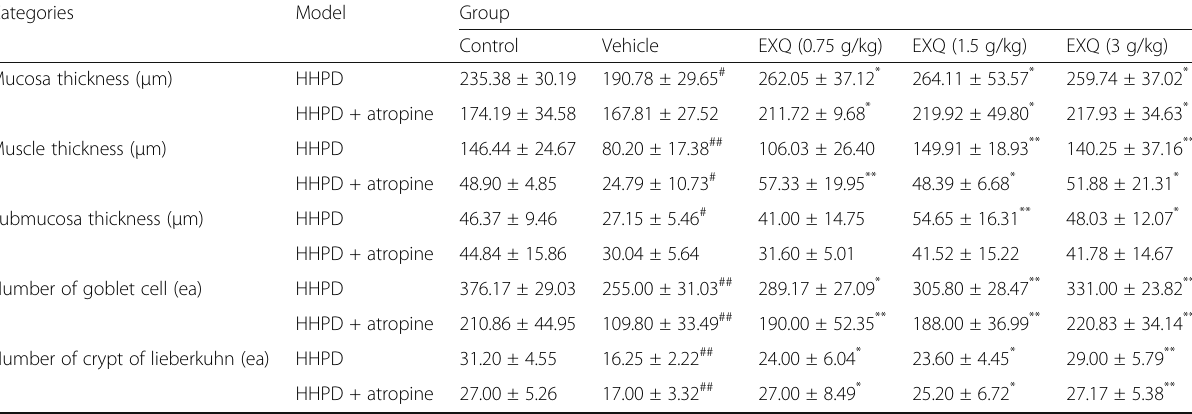
Table 2 Histopathological alteration of the constipated mice after EXQ treatment Categories